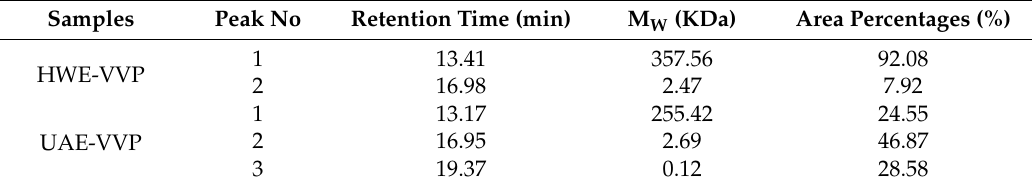
Table 3. Retention time, Mw and amount of soluble polysaccharide fractions extracted with ultrasound-assisted extraction (UAE) and hot water extraction